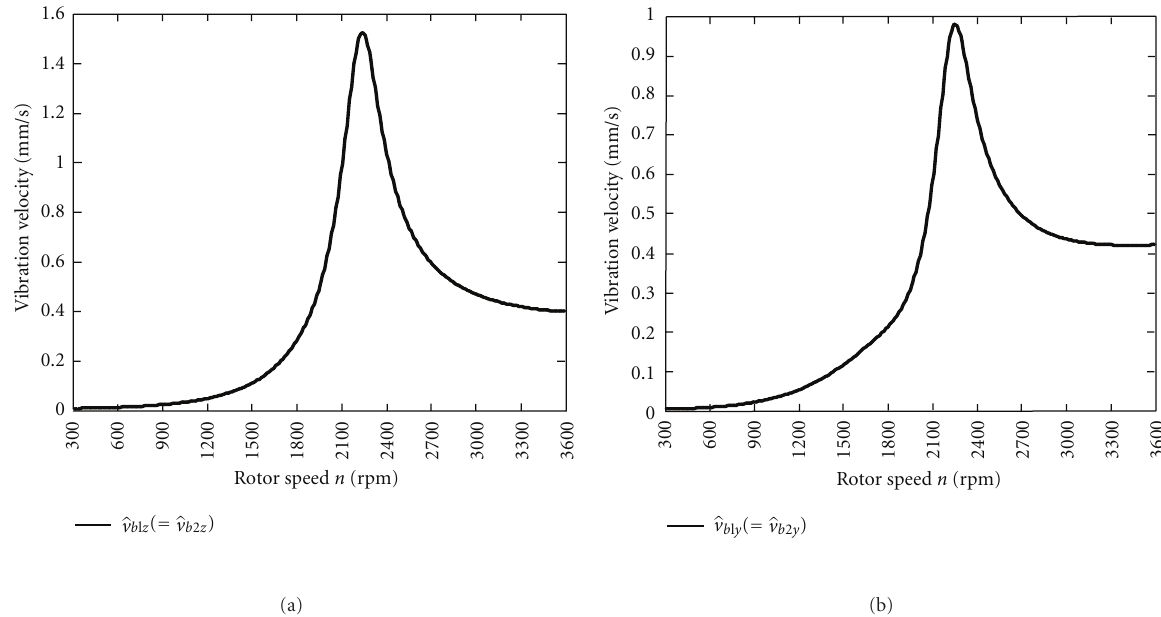
Figure 14: Bearing housing velocities in (a) vertical direction ( z -direction), (b) in horizontal direction ( y -direction). Boundary condition: identical orientation of the elliptical shaft journals ( ϕ 1 = ϕ 2 ) and di ff erent rotor speeds n .